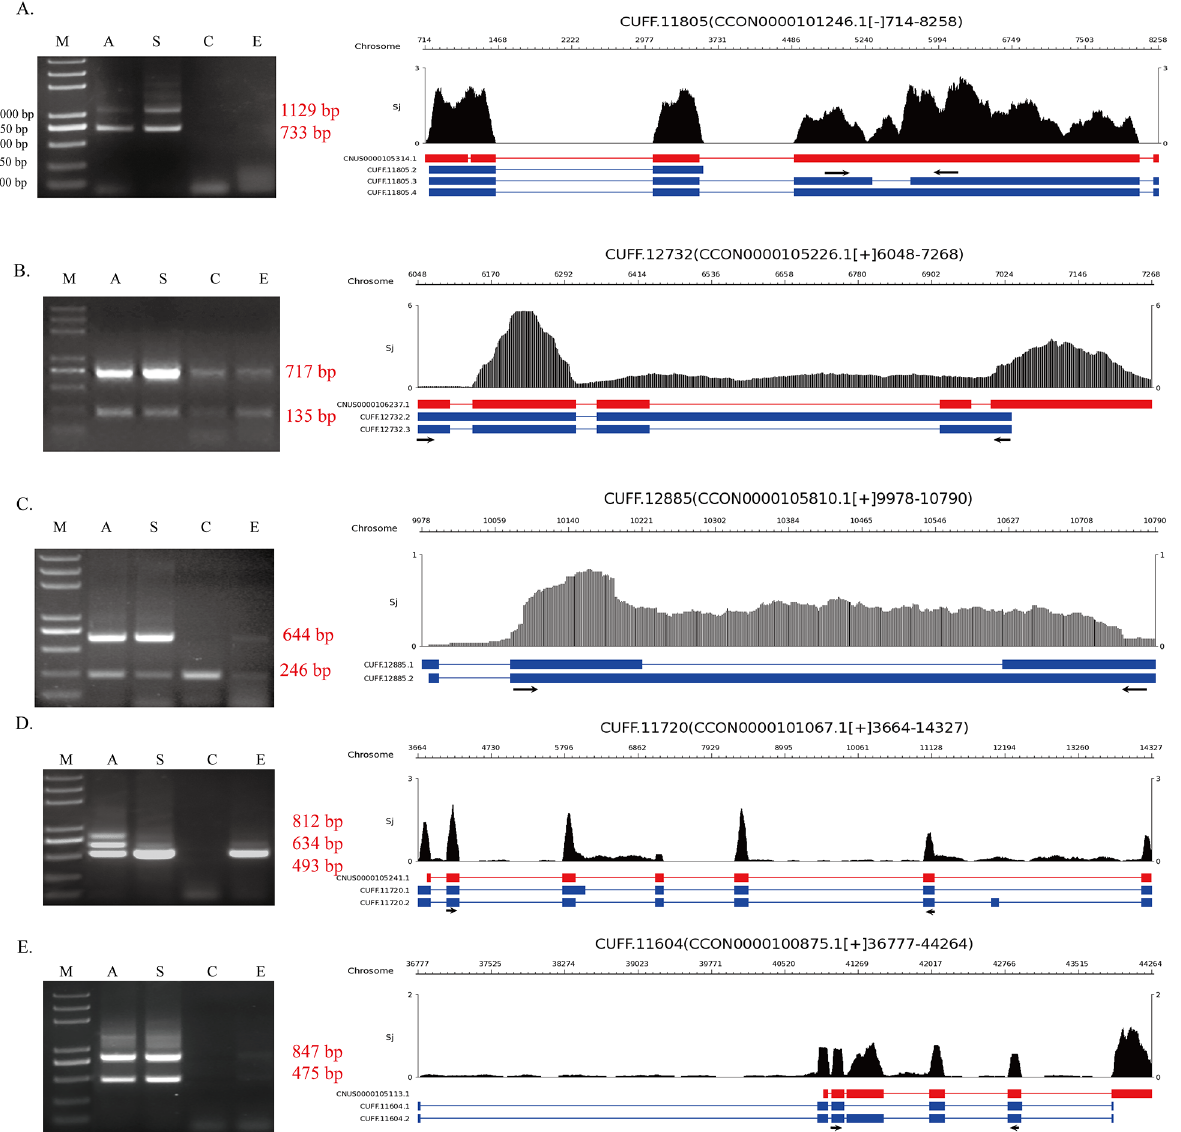
Fig 3. PCR identification of alternative spliced genes. Five examples are shown in the figure that represent different kinds of AS events: A and B, intron retention, C, new transcripts, D, alternative donor site, E, exon skip. PCR products of cDNAs of four life stages of S . japonicum were monitored by 1.5% agrose gel electrophoresis. Marker size was shown in first gel photo on left. Predicted products lengths are indicated in red font in right side of each gel photo, and arrows in the gene sketchs indicates where primers were designed. M: Marker; A: Adults; S: Schistosomula; C: Cercariae; E: eggs.